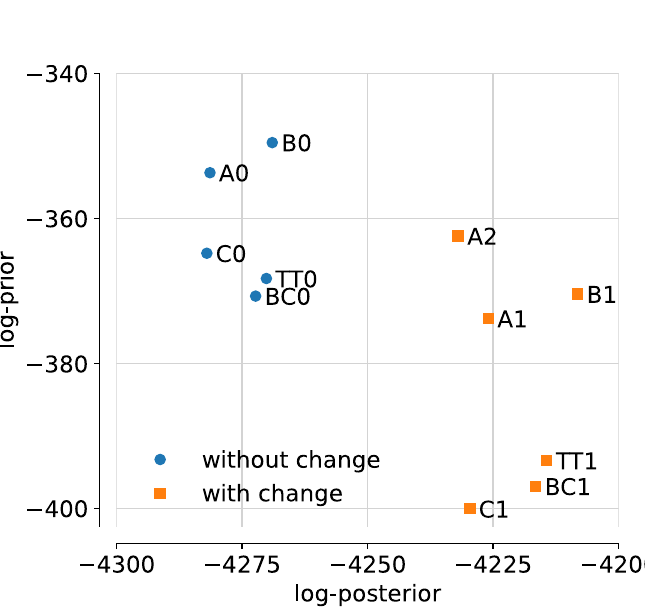
Fig 2. Plot of log-posterior and log-prior. Models without change in IFR in blue, models with change in IFR in orange.